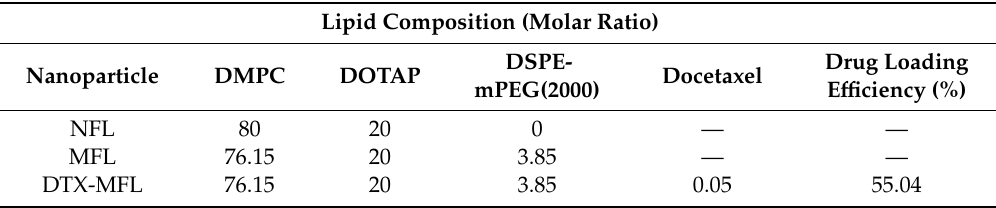
Table 2. Lipid compositions and drug-loading e ffi ciency of